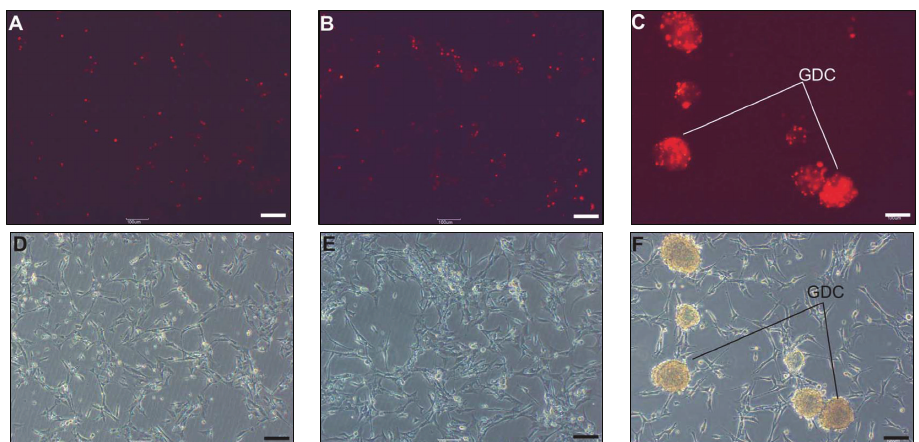
Figure 5: Subculture of frozen germ cell-derived colonies. The cells from frozen colonies, which were labeled with red trackers in passage 13, were maintained in the colonies of passage 14 ((A), (B), and (C)). Panels (D), (E), and (F) show the bright-field images of panels (A), (B), and (C), respectively. Scale bars indicate 100 𝜇 m in all the panels. GDC: germ cell-derived